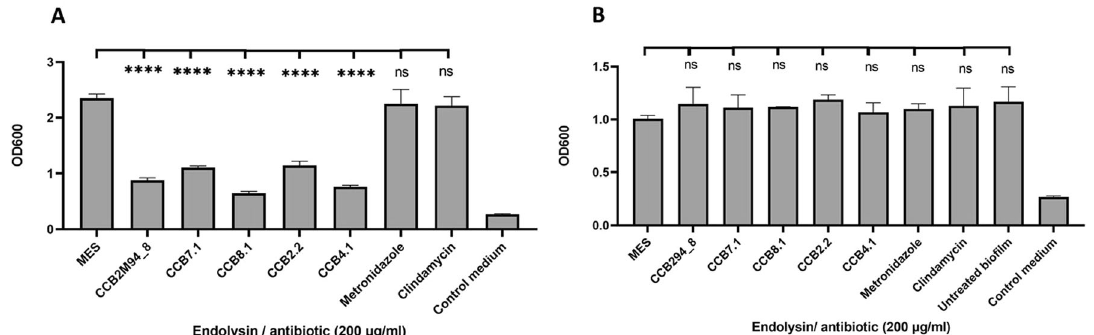
Fig. 7 Polymicrobial bio fi lm disruption. A Bio fi lm disruption assay using G. vaginalis ATCC14018 and A. vaginae UG71161 polymicrobial bio fi lms. The different endolysin candidates, metronidazole and clindamycin were used in a fi nal concentration of 200 μ g/ml. B Bio fi lm disruption assay using A. vaginae UG71161 bio fi lms. The different endolysin candidates, metronidazole and clindamycin were used in a fi nal concentration of 200 μ g/ml. OD 600 readings are the average of biological triplicates plus/minus their standard deviation. The asterisks in fi gures indicate levels of signi fi cance. p -values < 0.05 are represented by *, p- values < 0.01 are represented by **, p -values < 0.001 are re p resented by *** and p -values < 0.0001 are represented by ****. No statistical differences are represented by ns. p -values for ANOVA and Tukey tests.